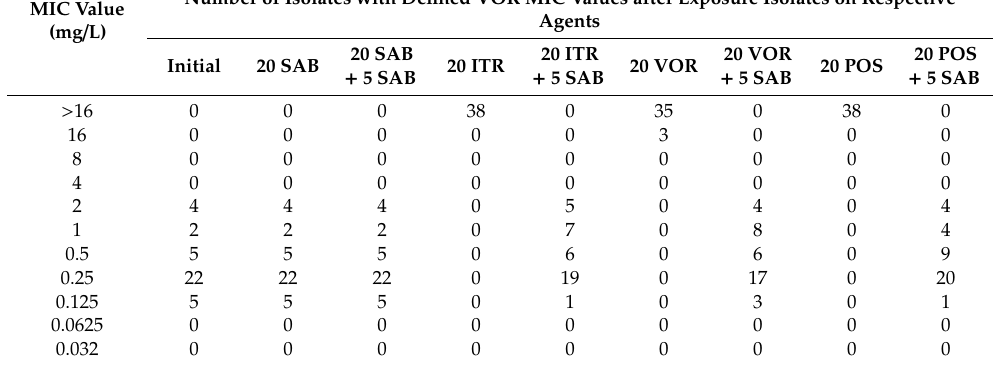
Table 6. The e ff ects of exposure to subinhibitory concentrations of ITR, VOR or POS on the MIC values for the respective